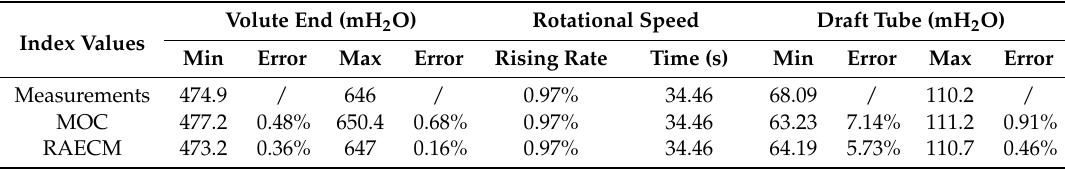
Table 2. The index values of transient process with different models in pump outage conditions.